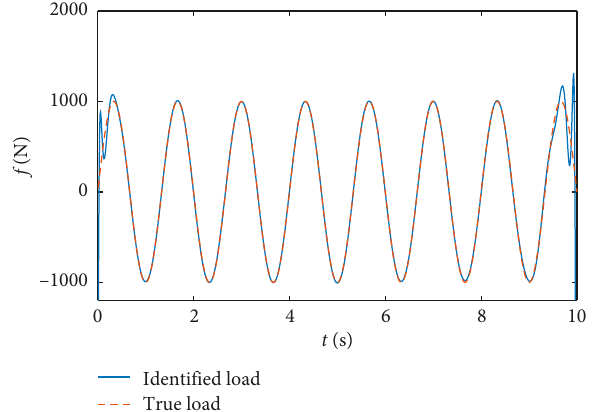
Figure 5: A comparison of the identified load with the true load using the displacement. Table 3: Identified errors using the acceleration and displacement. Response type